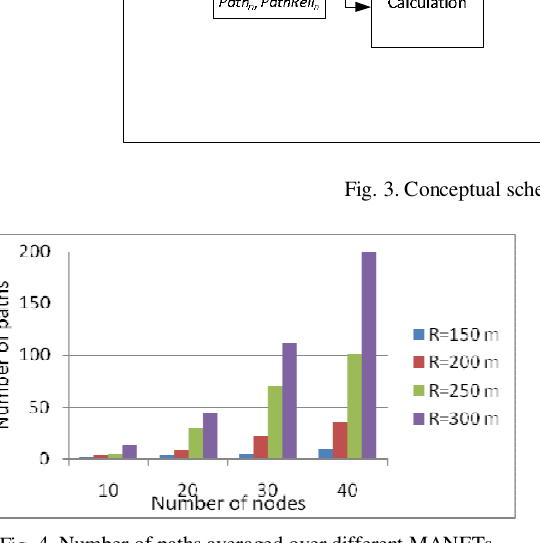
Fig. 4. Number of paths averaged over different